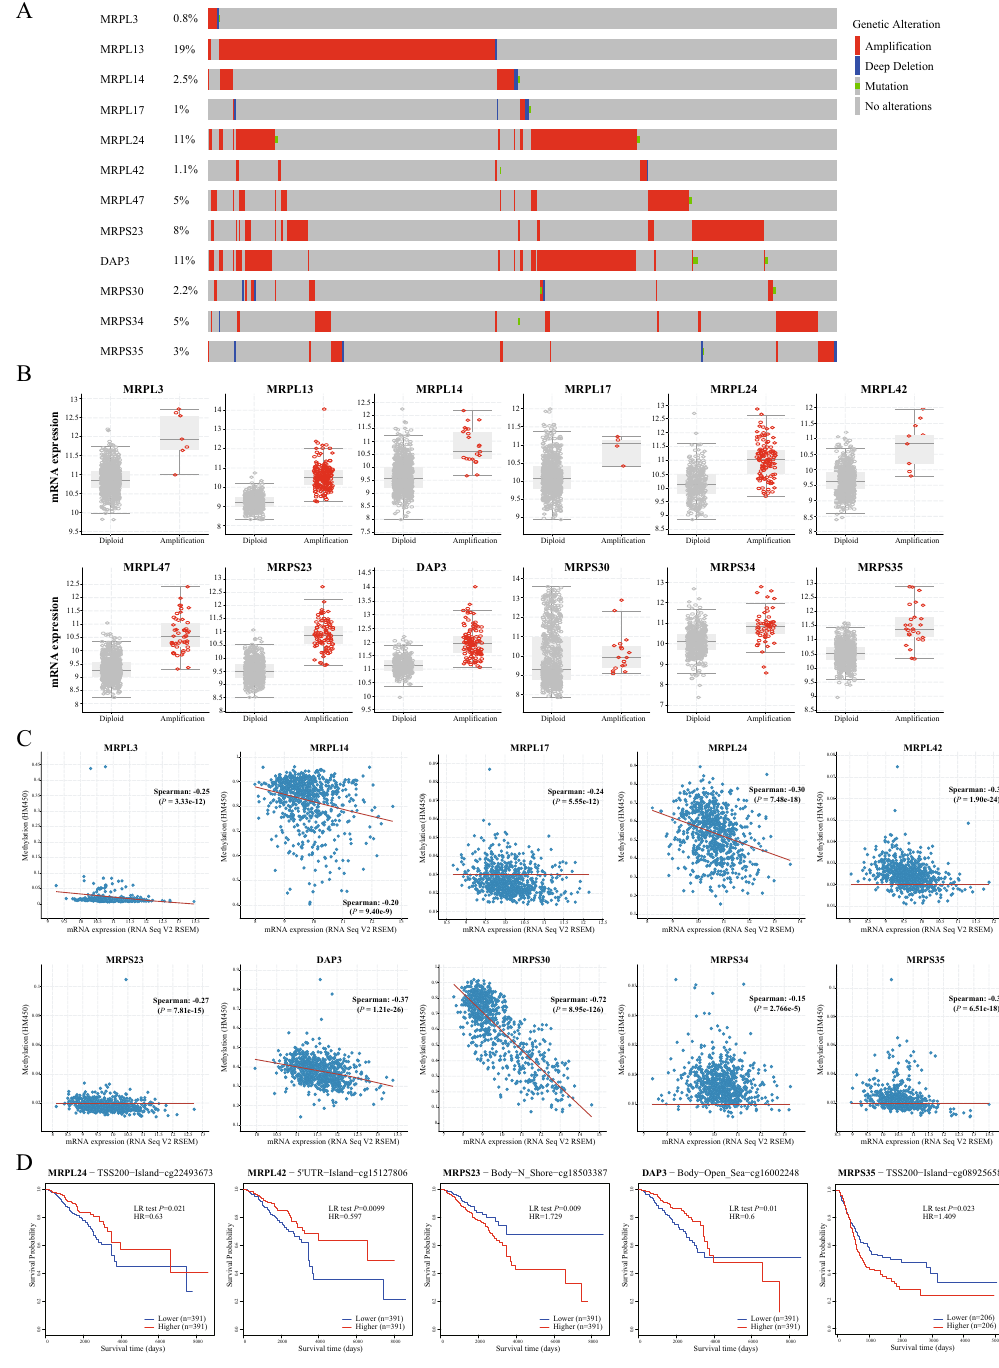
Figure 2. Gene alteration and methylation of MRP genes in breast cancer. ( A ) Summary of alteration patterns. The proportion of samples with genetic alteration was expressed as a percentage next to the gene, and genetic alteration types were indicated in bars with different colors. ( B ) The impact of gene amplification on the transcriptional level. Grey and red circles represented the mRNA expression in samples with diploid genotype and gene amplification. ( C ) Correlation between DNA methylation and mRNA expression in breast cancer. Each sample was indicated in a blue dot, and the fitted line was in red. The Spearman correlation coefficient and P value examined the association. ( D ) Kaplan–Meier plots showing overall survival in BC patients with hypermethylation (red curves) and hypomethylation (blue curves) for cg22493673-MRPL24, cg15127806- MRPL42, cg18503387-MRPS23, cg16002248-DAP3, and cg08925658-MRPS35. Log-likelihood ratio (LR) test P values were used to determine the prognostic significance and the hazard ratio (HR) was a relative prognostic measure of BC patients with hypermethylation compared with those with